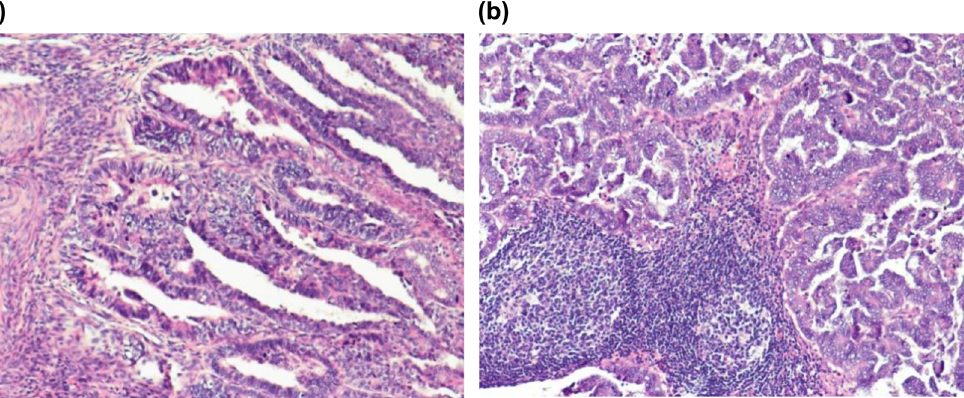
Figure 2: Postoperative pathology images. ( a ) HE staining of the uterus after surgery showed that the tumor invaded more than half of the muscle layer, and some reached the serosa layer. Magni fi cation: 100 × . ( b ) Lymph node metastasis after the tumor surgery, shown by HE staining. Magni fi cation: 100 ×